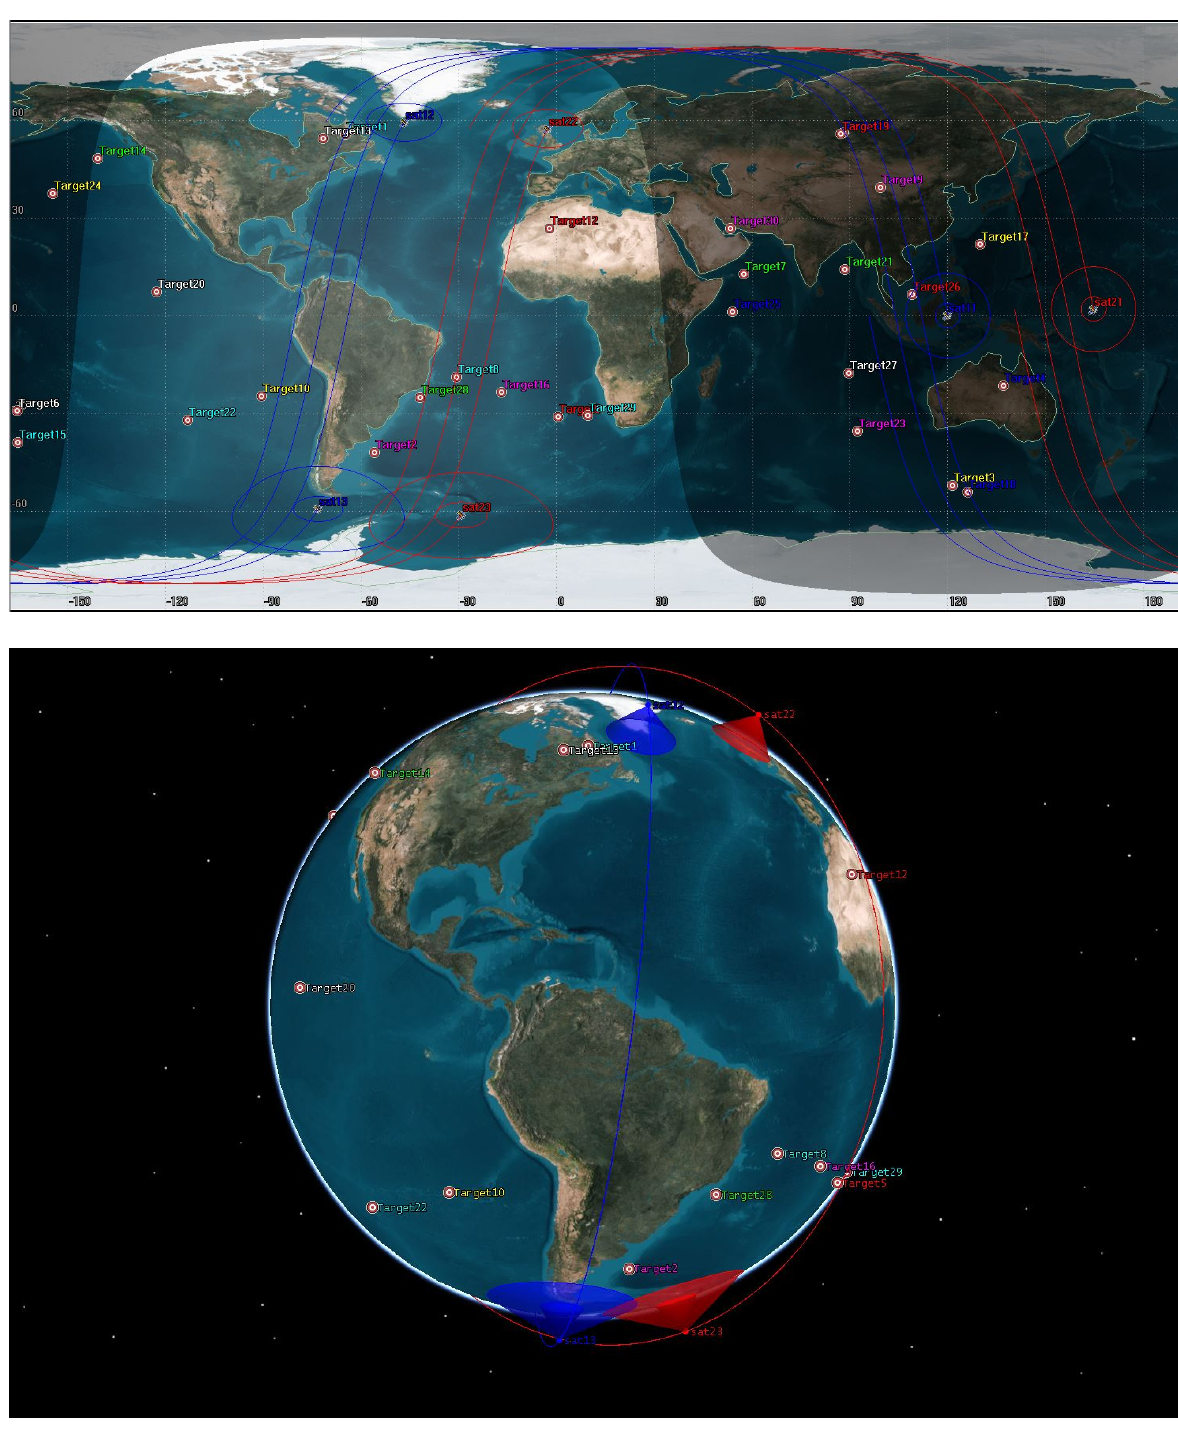
Figure 5. Test scenario